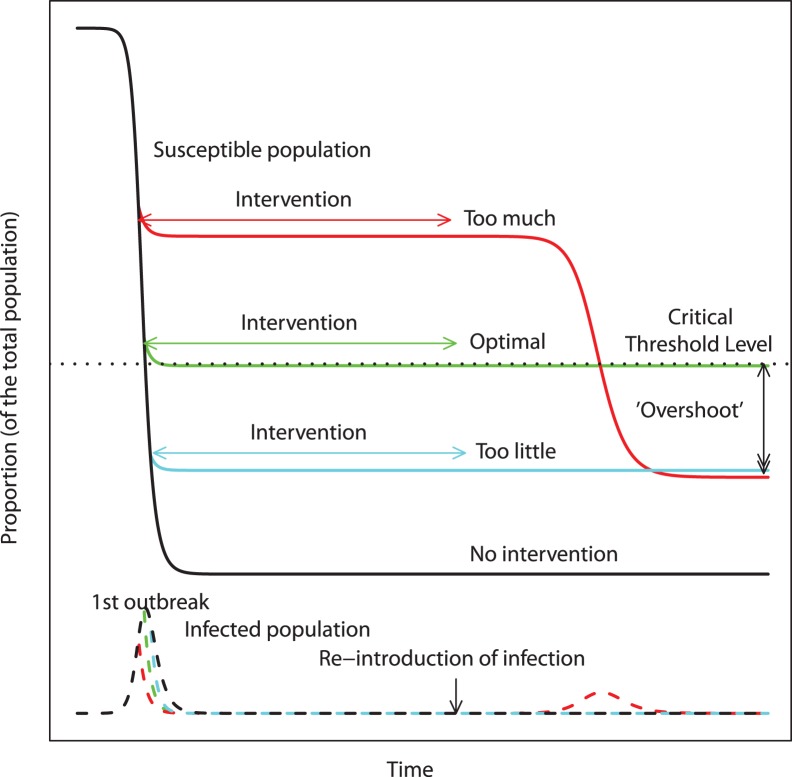
Illustration of the concept of optimal control for multiple outbreaks.We assume that multiple outbreaks can occur, with the intervention only being feasible during the first outbreak. If the intervention is weak (or absent), the first outbreak will be large enough to deplete the number of susceptible people below a critical threshold level (the herd immunity level below which effective reproduction number <1), such that if the infection is re-introduced, its effective reproductive number would be too low to cause a second outbreak (black and cyan lines). If the intervention is very strong, it is possible that after the first outbreak, the number of susceptible people remaining is large enough to support a second (uncontrolled) outbreak upon re-introduction of the pathogen, leading to an overall number of people infected that might be the same as that reached during just one outbreak (red line). In both the “too much” and “too little” intervention scenarios, the number of susceptible people drops below the critical threshold level, which defines the level of herd immunity. The excess drop is termed ‘overshoot’. The optimal intervention is one that minimizes the overshoot by allowing the susceptible population to drop to the critical threshold level during the first outbreak, such that a second outbreak cannot occur (green line). The solid lines represent the susceptible people and the broken lines represent the infected people.